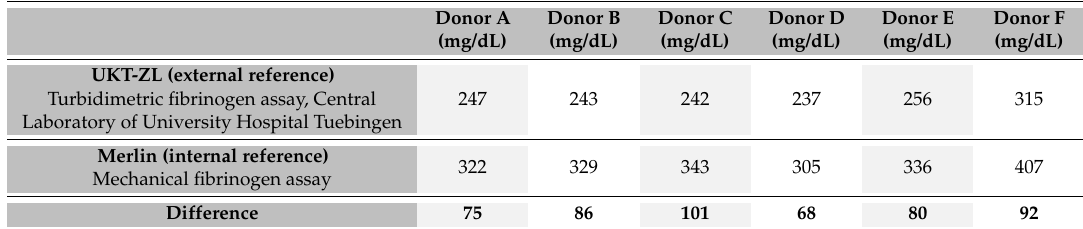
Table 2. Numeric overview of shifts between fibrinogen results of laboratory internal Merlin coagulometer (Merlin) and the external central laboratory of the university hospital (UKT-ZL).